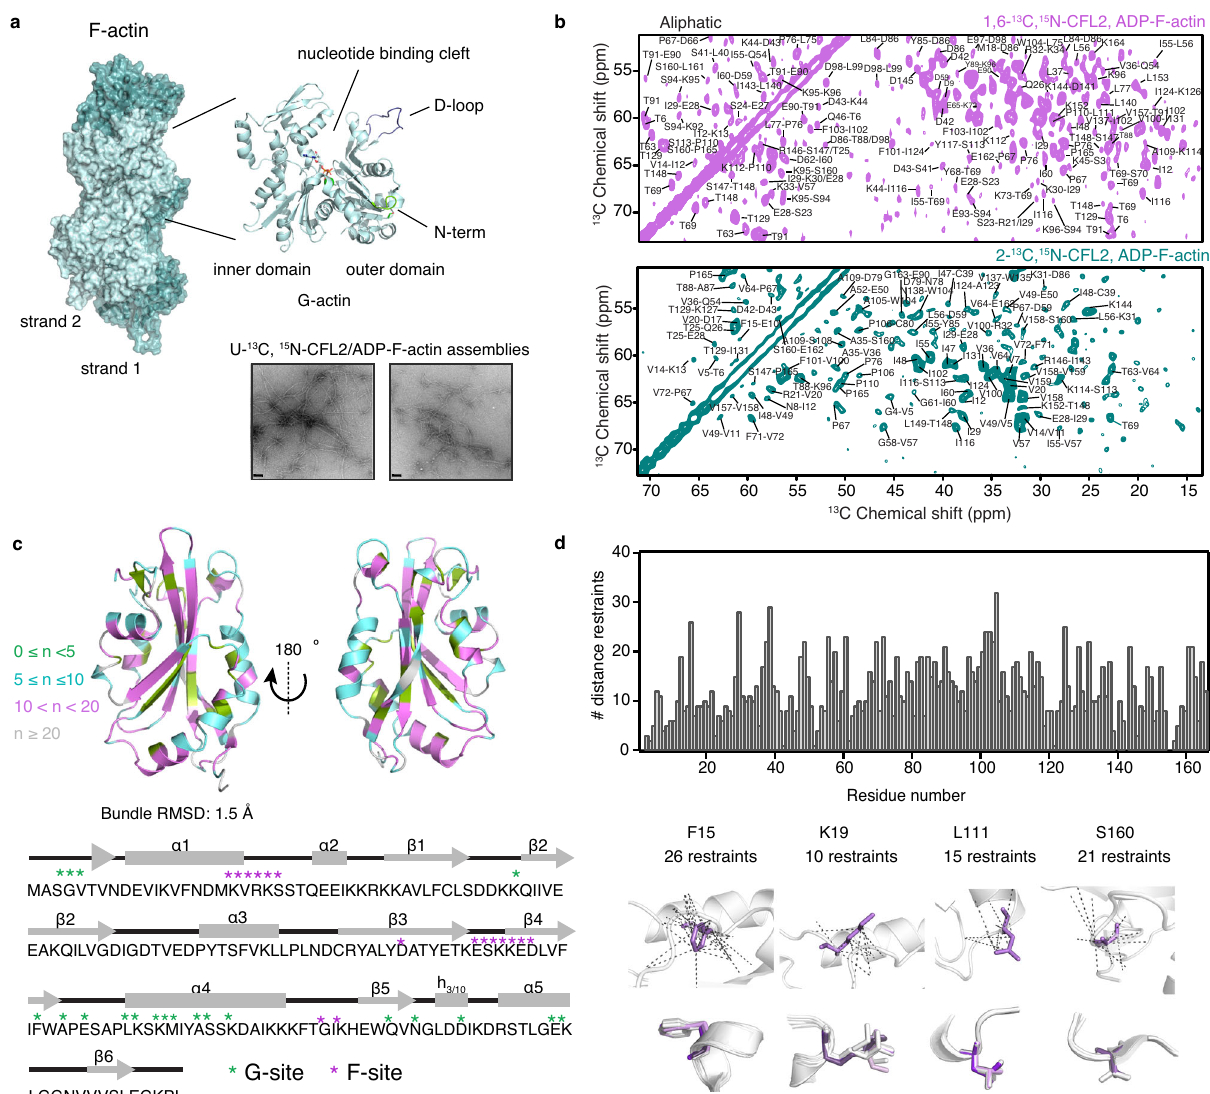
Fig. 1 MAS NMR structure of CFL2 bound to ADP-F-actin. a Top: Structure of F-actin (left, PDB ID: 5ONV), composed of G-actin monomers (right, PDB ID: 1ATN). Separate strands are designated in pale cyan and dark teal. Bottom: TEM images of co fi lactin assemblies used for MAS NMR experiments. A representative image before (left) and after (right) MAS NMR experiments is shown (scale bars: 100 nm). TEM images were collected on three independent preparations with similar results. b 2D 13 C- 13 C CORD spectra acquired on CFL2 samples labeled with 1,6- 13 C-glucose (magenta) and 2- 13 C-glucose (teal) used for inter-residue distance restraints (CORD mixing time, 50 ms). Selected assignments are labeled on each spectrum. c Top: Ribbon representation of the lowest energy structure of CFL2 bound to ADP-F-actin (PDB ID: 7M0G). The number of unambiguous distance restraints are designated on the structure ranging from 0 – 5 restraints per residue (green) to greater than 20 restraints per residue (gray). Bottom: Sequence and secondary structure elements of CFL2. Residues constituting the canonical G- and F- binding patches are indicated with green and violet asterisks, respectively. d Top: Number of unambiguous distance restraints versus residue number. Bottom: Distance restraint networks and local alignment of structure ensemble for selected